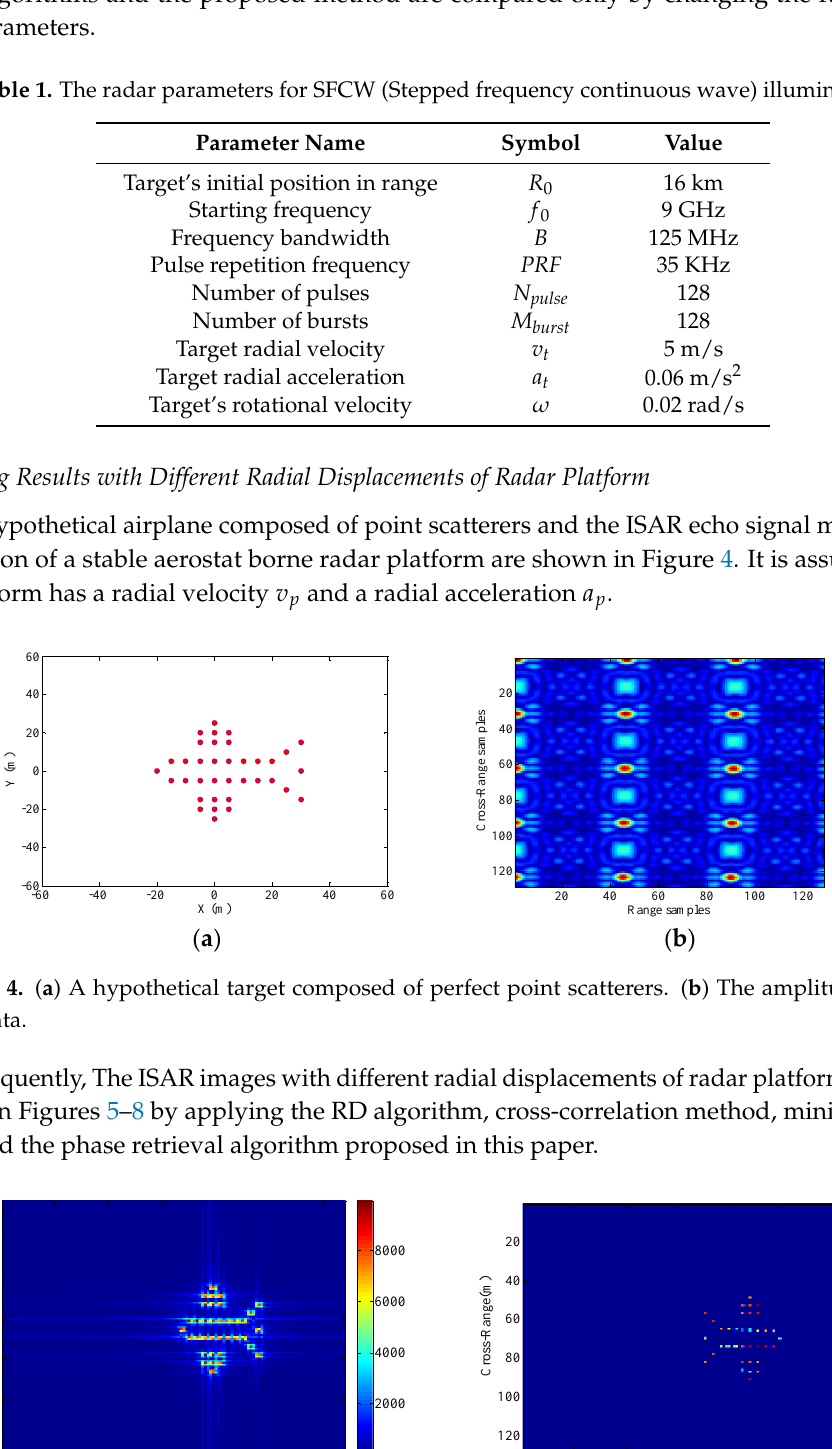
Table 1. The radar parameters for SFCW (Stepped frequency continuous wave) illumination.